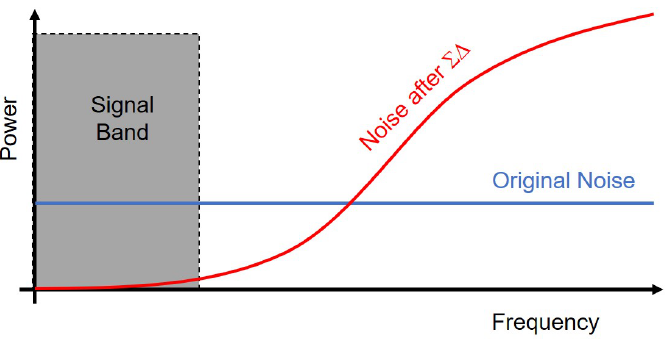
Figure 13. The sigma delta modulator shapes the noise power by moving the low frequency noises to the high frequency region. Therefore, the SNR at the signal band is improved by means of low-pass filtering.